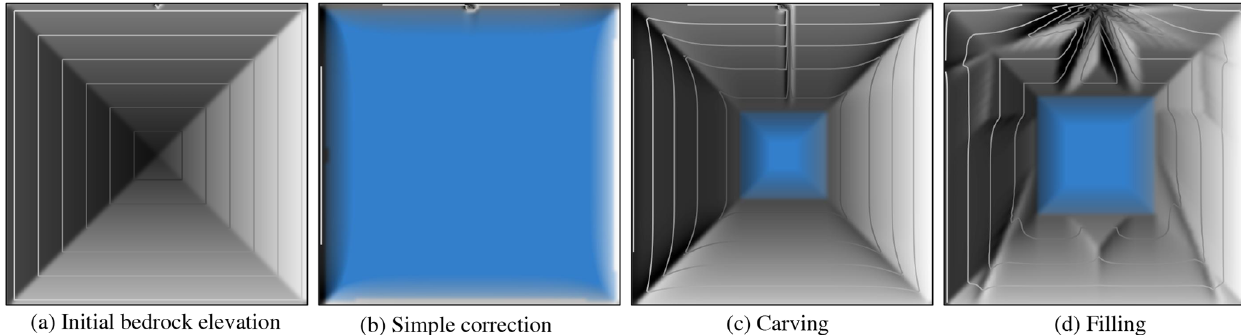
Figure 4. Demonstration of the effect of flow path enforcement on erosion, using different strategies of flow receivers “correction” within inner basins. (a) Hillshade and contour plot of the initial topography. (b) , (c) and (d) Hillshade and contour plot of the topography obtained after running a single time step of 5000 years with channel erosion only (no uplift), with flow receivers updated using each of the different strategies described in Sect. 2.3. Water level is shown in blue, and is computed by propagating the spill elevation while parsing the nodes in the upstream order (based on updated